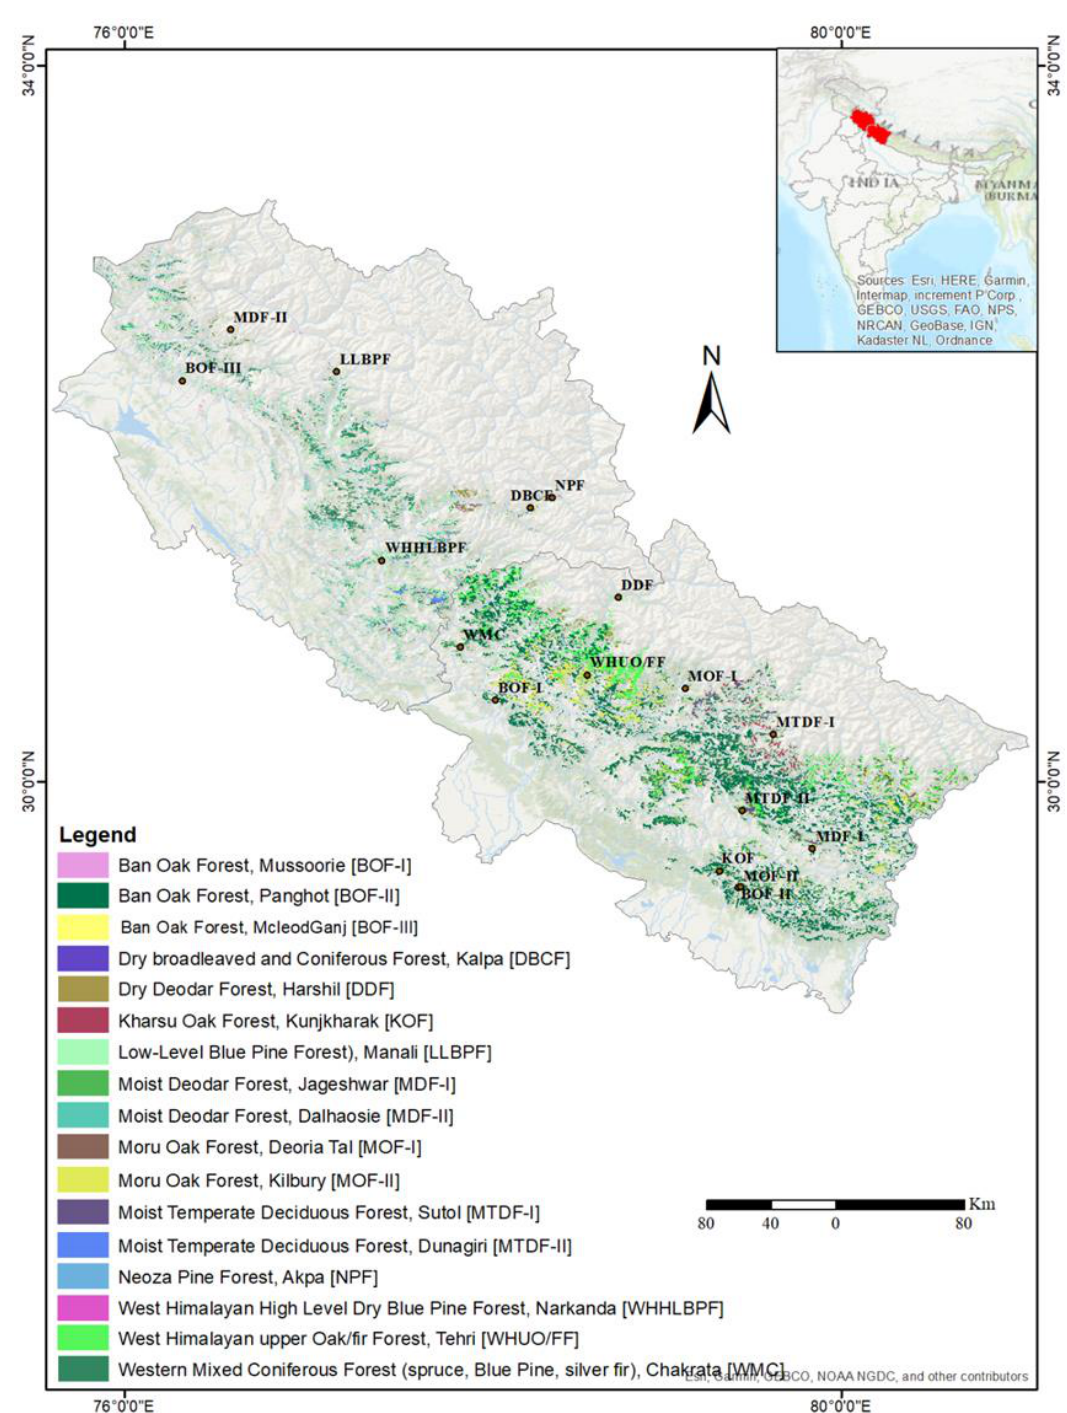
Figure 1. Study area of the selected forests.